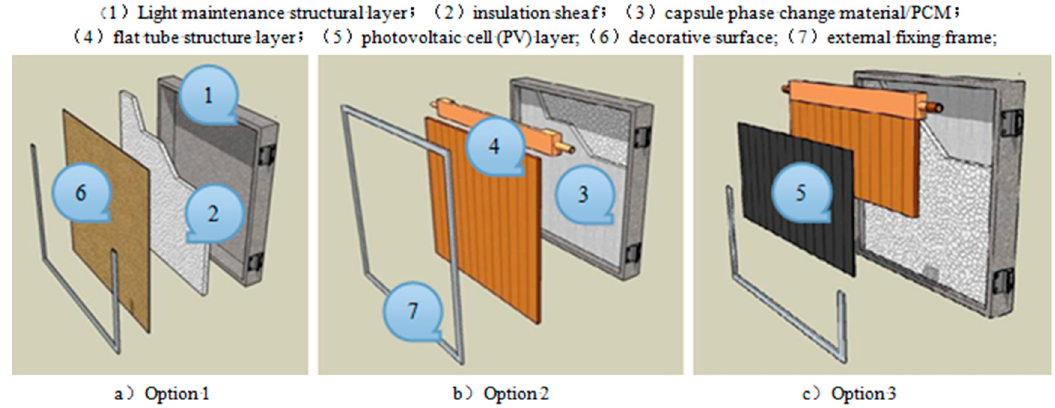
Figure 1. Schematic of a novel modular solar building envelope.